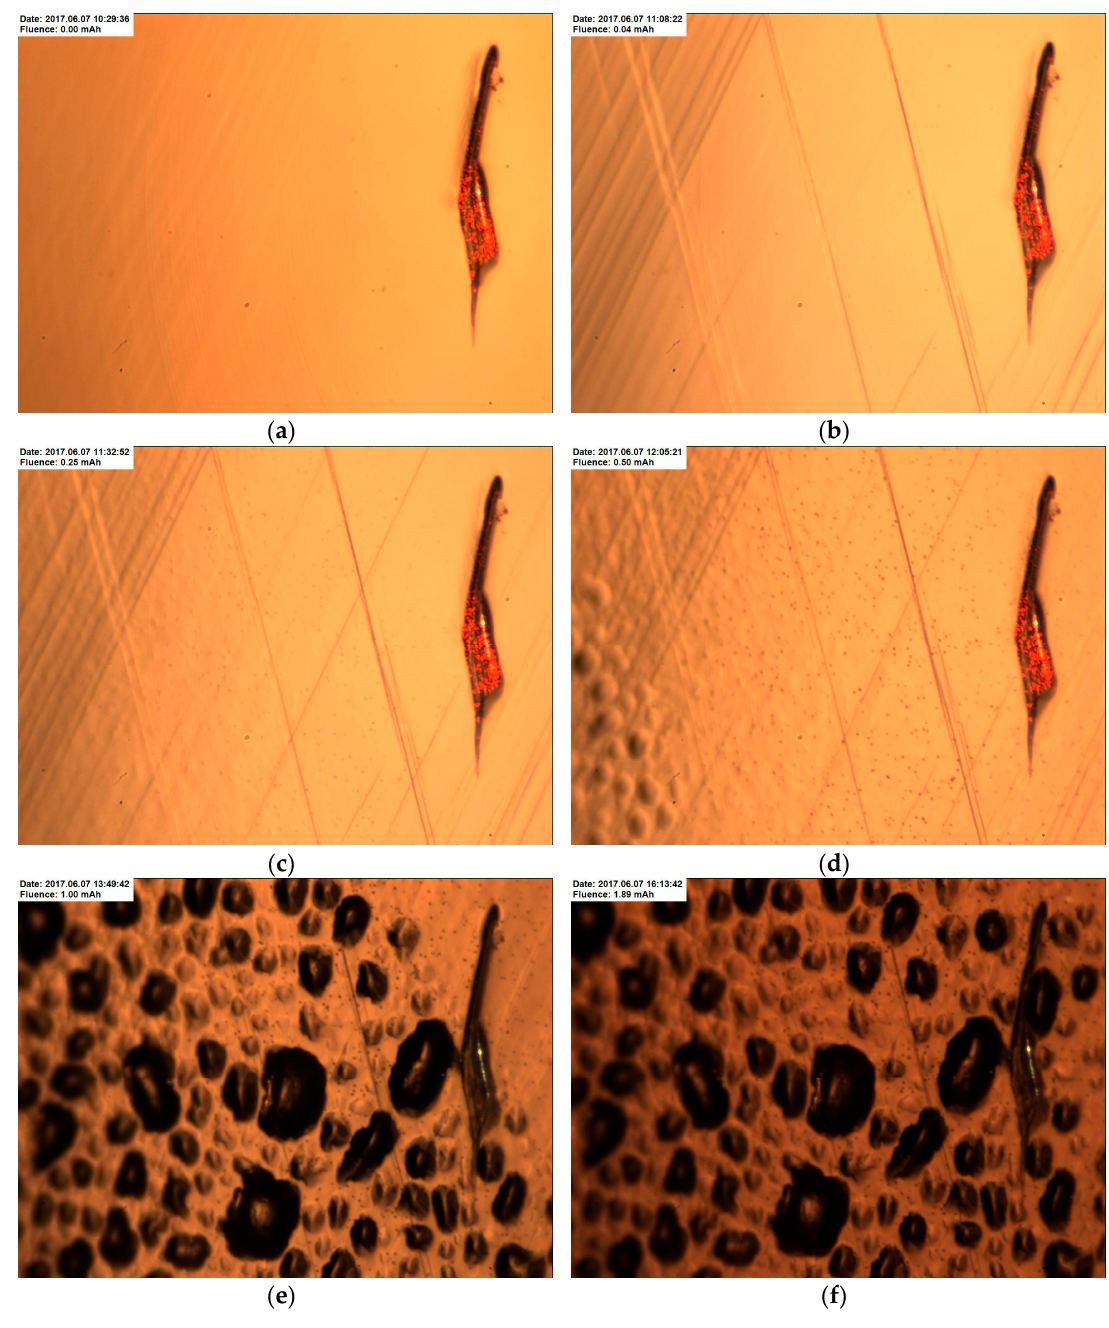
Figure 11. Images of the surface of 99.99996% coarse copper (Sample 2) during irradiation by a 2-MeV proton beam with varying integrals of the current: ( a ) 0, ( b ) 0.04, ( c ) 0.25, ( d ) 0.50, ( e ) 1.00, ( f ) 1.89 mA · h. The frame size is 9 mm horizontally and 4 mm vertically.